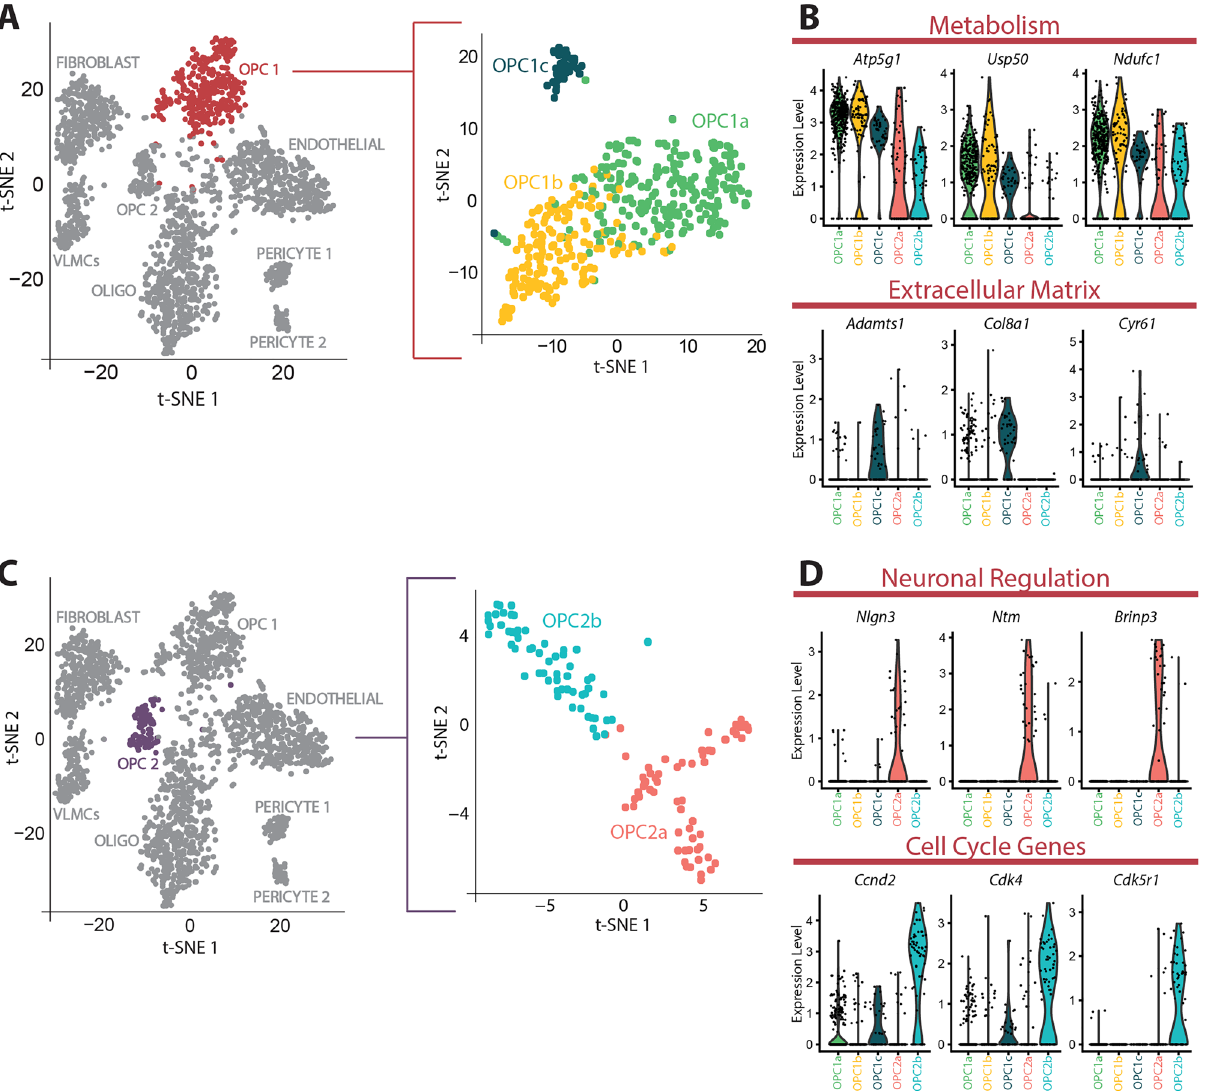
Figure 4. Subclustering reveals potential functions of OPCs. ( A ) Subclustering of OPC1 into 3 subclusters (OPC1a, OPC1b, and OPC1c). ( B ) Violin plots depicting expression of genes related to metabolism that are significantly upregulated in OPC1a and genes related to the extracellular matrix that are significantly upregulated in OPC1c. Each dot represents a cell. ( C ) Subclustering of OPC2 into 2 subclusters (OPC2a and OPC2b). ( D ) Violin plots depicting expression of genes related to neuronal regulation that are significantly upregulated in OPC2a and genes related to the cell cycle that are significantly upregulated in OPC2b. Each dot represents a